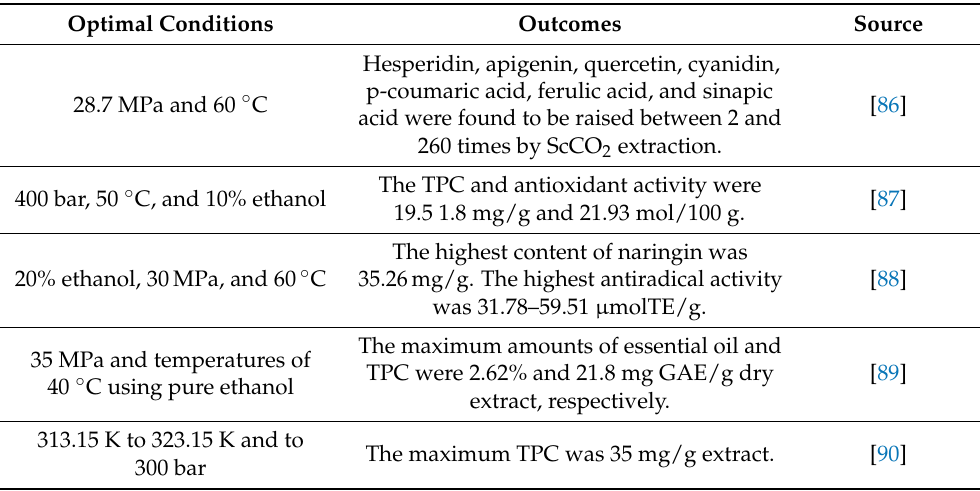
Table 4. The optimal parameters and outcomes in orange peel extraction by ScCO 2